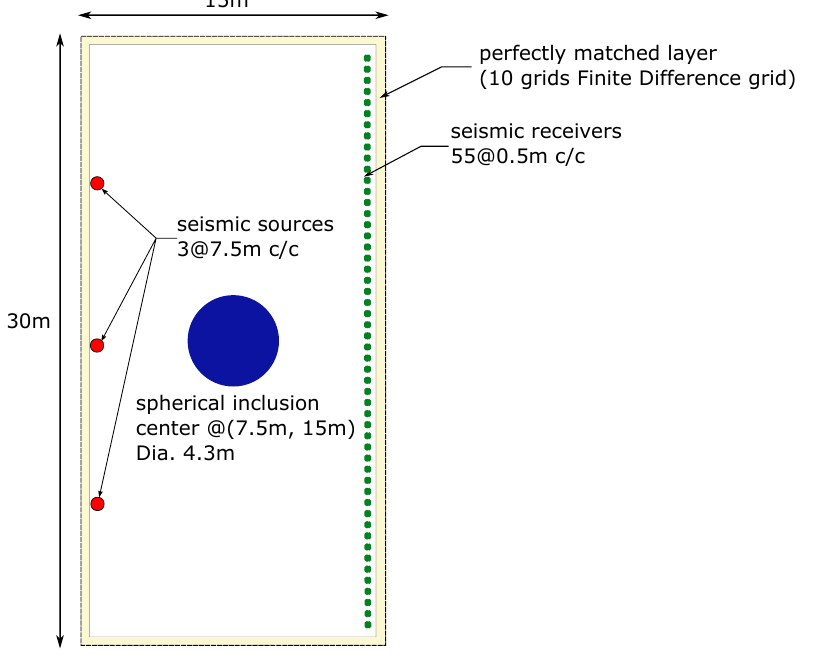
Figure 13. A spherical inclusion in a rectangular finite difference grid considered for FWI simulation.